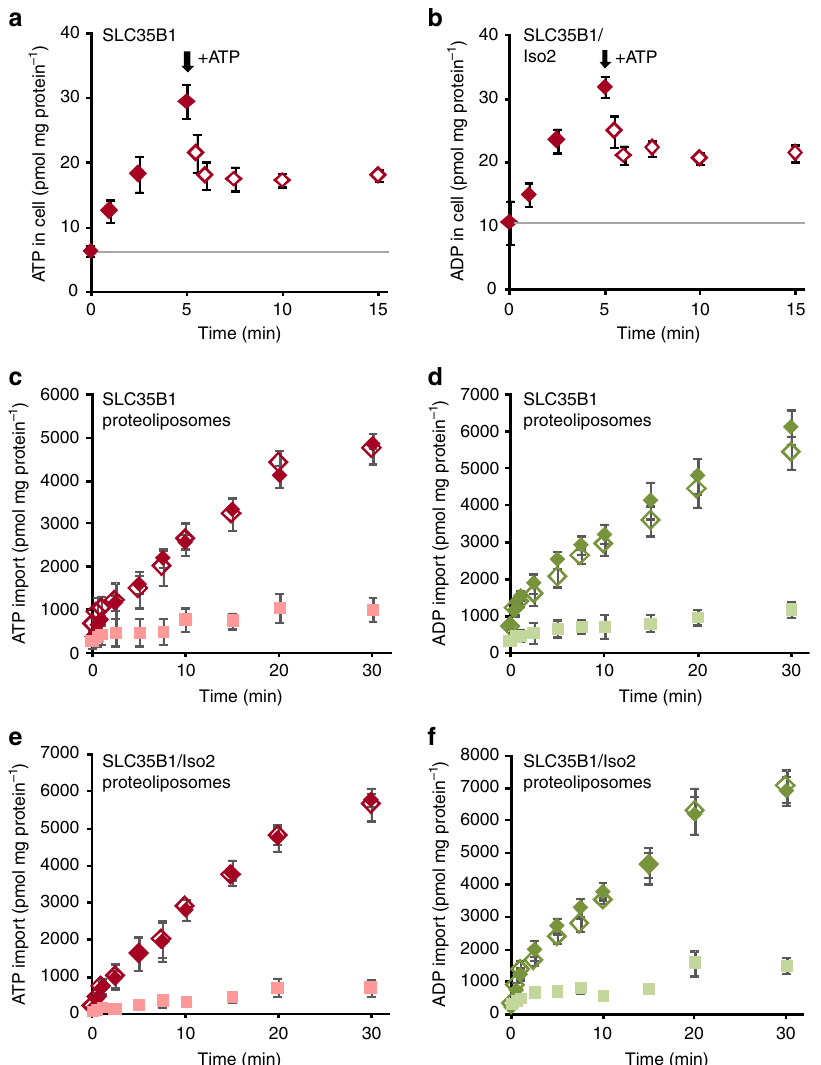
Fig. 3 Heterologously expressed SLC35B1 and SLC35B1/Isoform 2 are antiporters for ADP and ATP. a , b After 5 min of uptake of 20 µ M [ α 32 P]ATP as described in Fig. 2, ef fl ux was induced by the addition of ten-fold molar excess of unlabeled ATP. Data are reported as the mean of at least three independent experiments and are shown with the standard error of the mean (SEM). See Supplementary Fig. 2 for the demonstration of ATP export into the cell supernatants under similar conditions. c – f Proteoliposomes harboring membrane proteins from SLC35B1 ( c , d ) or SLC35B1/Isoform 2 ( e , f ) transfected E. coli cells were prepared as described in Methods. Time dependent accumulation of 50 µ M [ α 32 P]-ATP in unloaded (pink) or preloaded proteoliposomes ( c , e ) or 50 µ M [ α 32 P]-ADP in unloaded (light green) or preloaded proteoliposomes ( d , f ). Proteoliposomes were preloaded with 10 mM ADP (empty rhombs) or 10 mM ATP ( fi lled rhombs). [ α 32 P]-ATP or [ α 32 P]-ADP was present at a concentration of 50 µ M. Uptake was terminated after 2 min. Data are reported as the mean of at least three independent experiments and are shown with the standard error of the mean